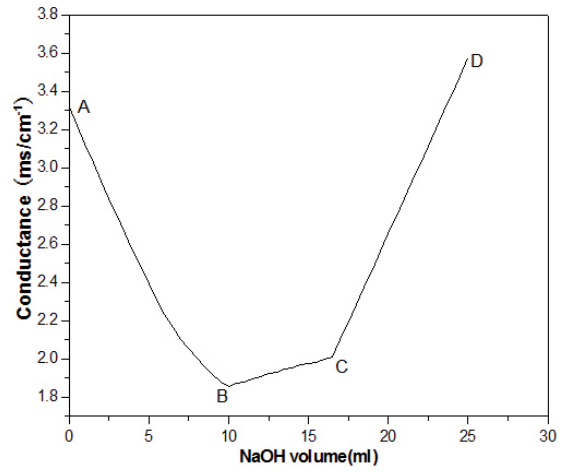
Figure 3. Conductometric titration curve of -COOH groups on the surface of magnetic microspheres.